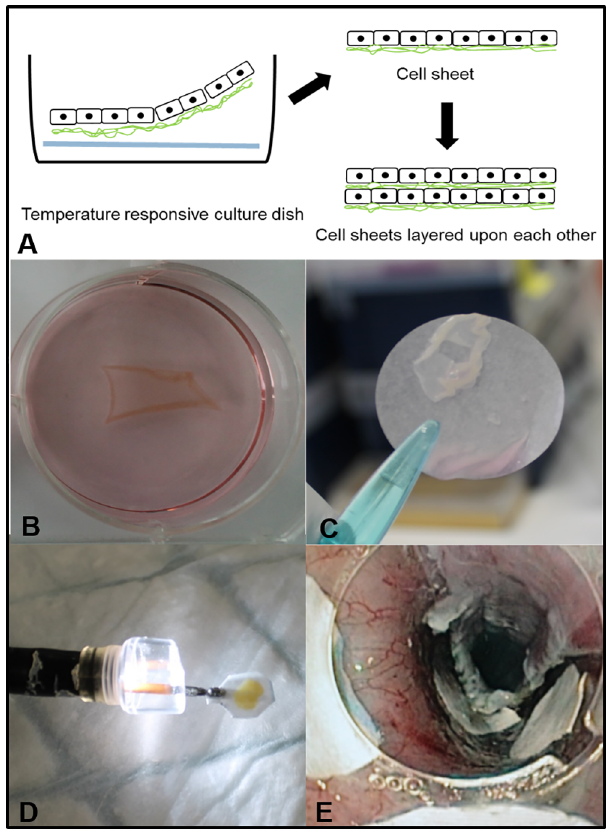
Fig 1. Transplantation procedure. A. Stem cell sheets were obtained by culturing PKH-labeled ADSC on commercial thermoresponsive culture dish. When the incubation temperature was reduced to 20°C (room temperature) all of the cultured cells spontaneously detached from the dish surfaces as intact ADSC sheets, without the need for enzymatic treatments. B. ADSC sheet completely detached from the dish surface. C. ADSC sheet harvested before graft construction using a transfer membrane. D. Protection of the graft under a large endoscopic cap before transplantation. E. Transplantation was allowed after a gentle graft application of ten minute using the endoscopic